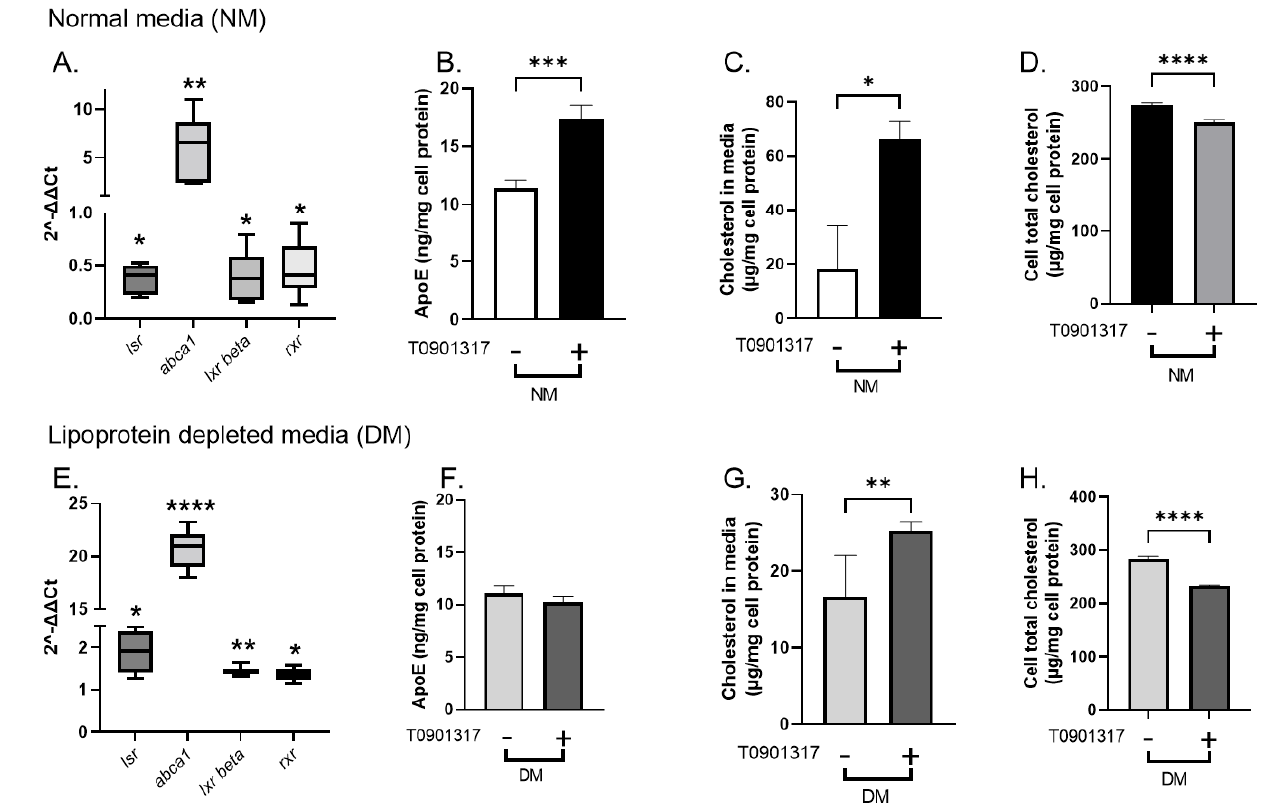
Figure 4. Effect of T0901317 on lsr expression in murine astrocytes expressing human ApoE3. Astrocytes were incubated 8 h at 37 ◦ C in the absence ( − ) or presence (+) of 1 µ M T0901317 in complete media (NM, ( A – D )) or in lipoprotein-depleted media (DM, ( E – H )). After 8 h incubation at 37 ◦ C, cells and media were removed and stored for analysis. Results of fold-expression changes in cells treated with T0901317 as compared to control cells (absence of T0901317) following qPCR analysis of target gene levels are shown in ( A , E ) for NM and DM media, respectively. ApoE and total cholesterol levels in the cell media expressed per mg cell protein and cell lipid extracts are indicated in ( B – D ) for NM and ( F – H ) for DM. Results are shown as mean ± SEM ( n = 6). Statistical differences are shown as: * p < 0.05, ** p < 0.01, *** p < 0.001, **** p < 0.0001 as compared to control cells.